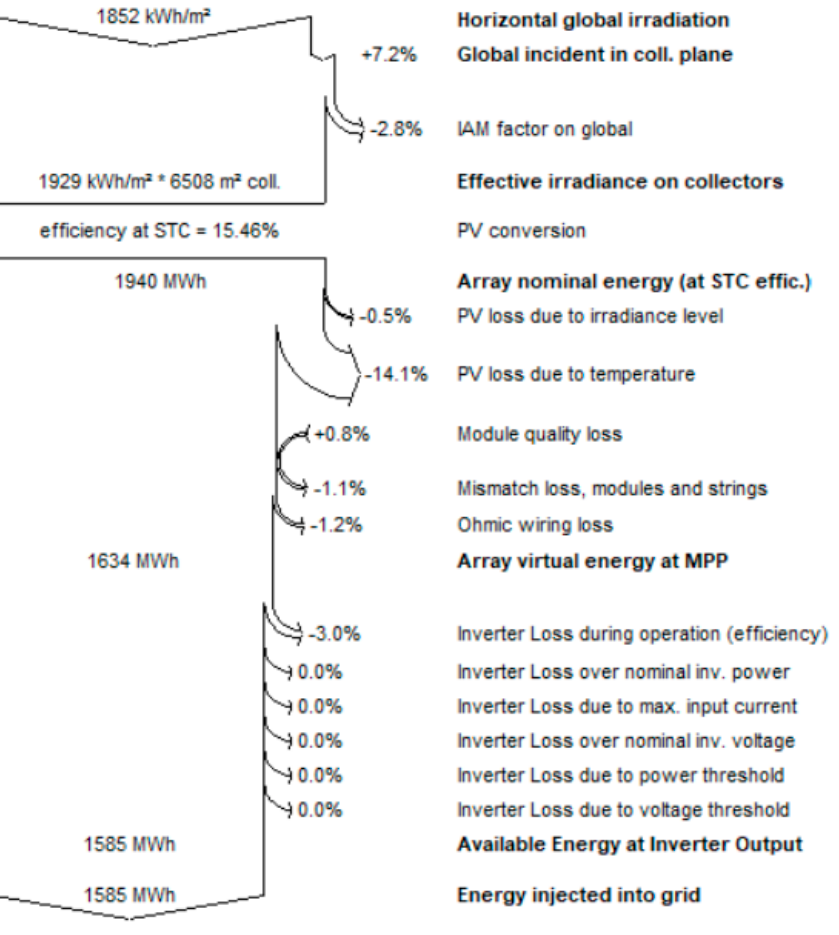
Figure 9. System loss diagram.